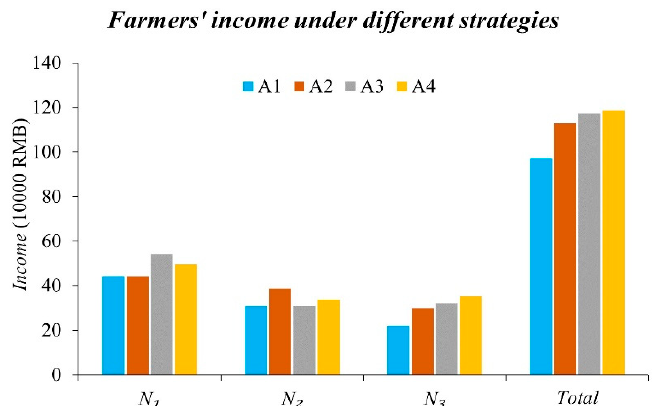
Figure 5. Revenue matrix of the Game Model of water rights transaction under different alliances.